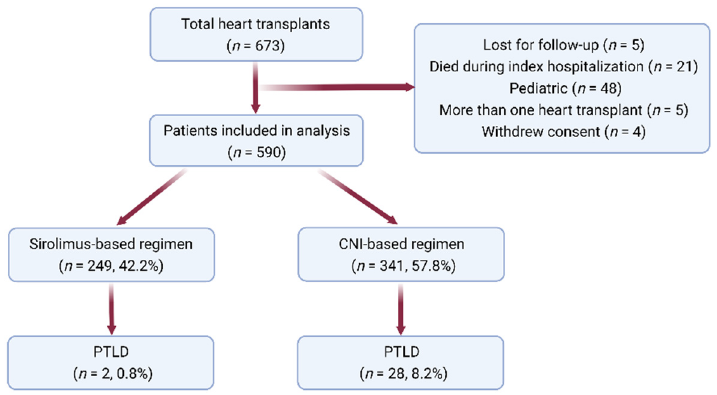
Figure 1. Flowsheet of the study. CNI, calcineurin inhibitor; PTLD, post-transplant lymphoproliferative disorder.